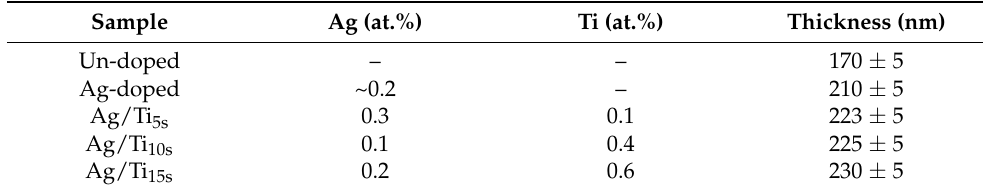
Figure 3. ( a – e ) Surface morphology images of the un-doped, single Ag-doped and the Ag/Ti co-doped thin films and ( f – f4 ) EDS mappings. Table 1. The element content and thickness of the thin films.